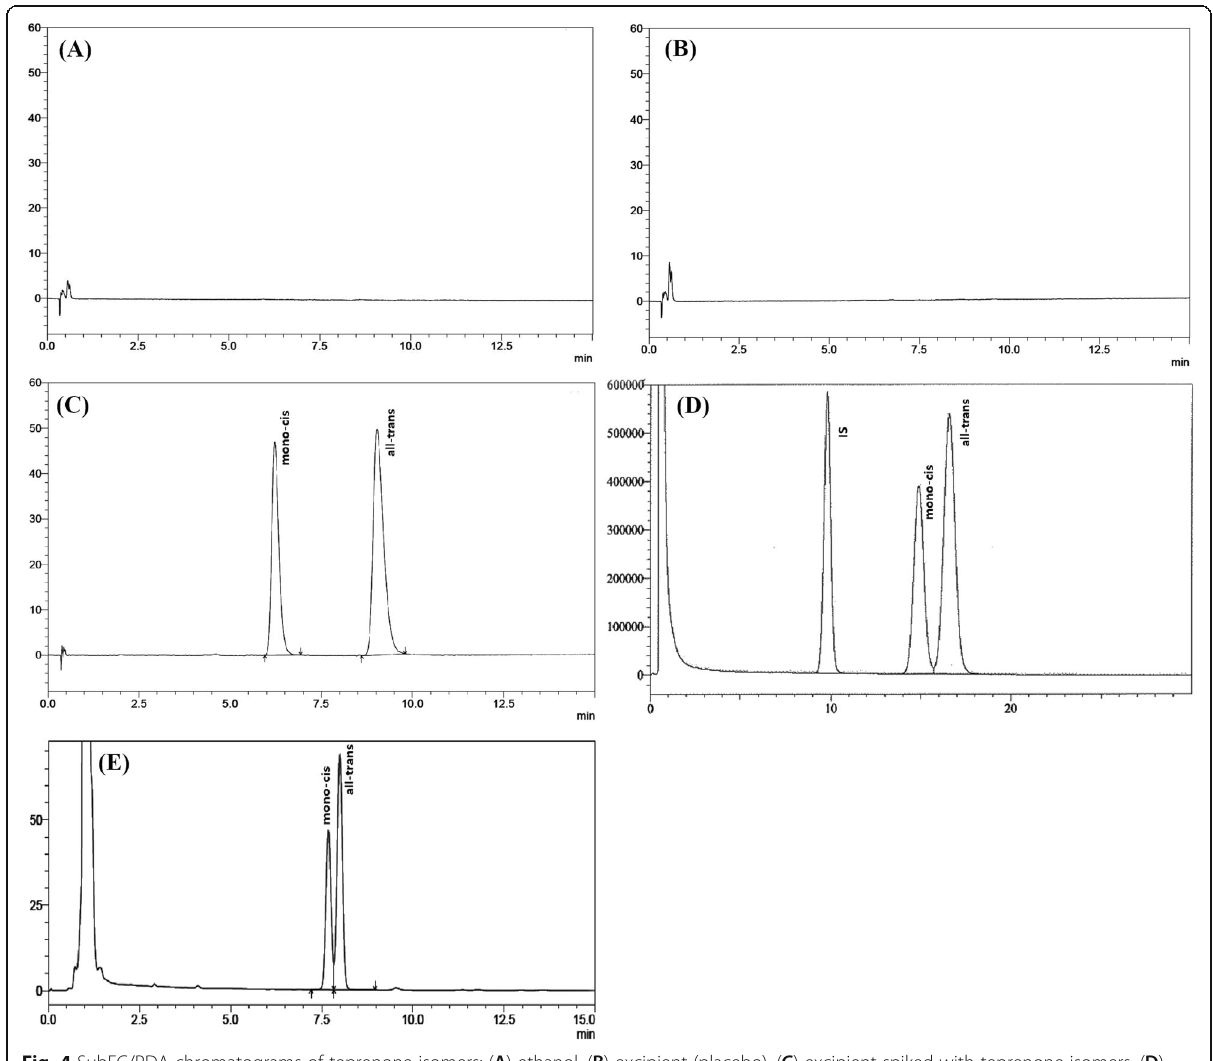
Fig. 4 SubFC/PDA chromatograms of teprenone isomers: ( A ) ethanol, ( B ) excipient (placebo), ( C ) excipient spiked with teprenone isomers, ( D ) GC/FID chromatogram using packed column for teprenone assay, and ( E ) HPLC/UV chromatogram at dissolution test of teprenone